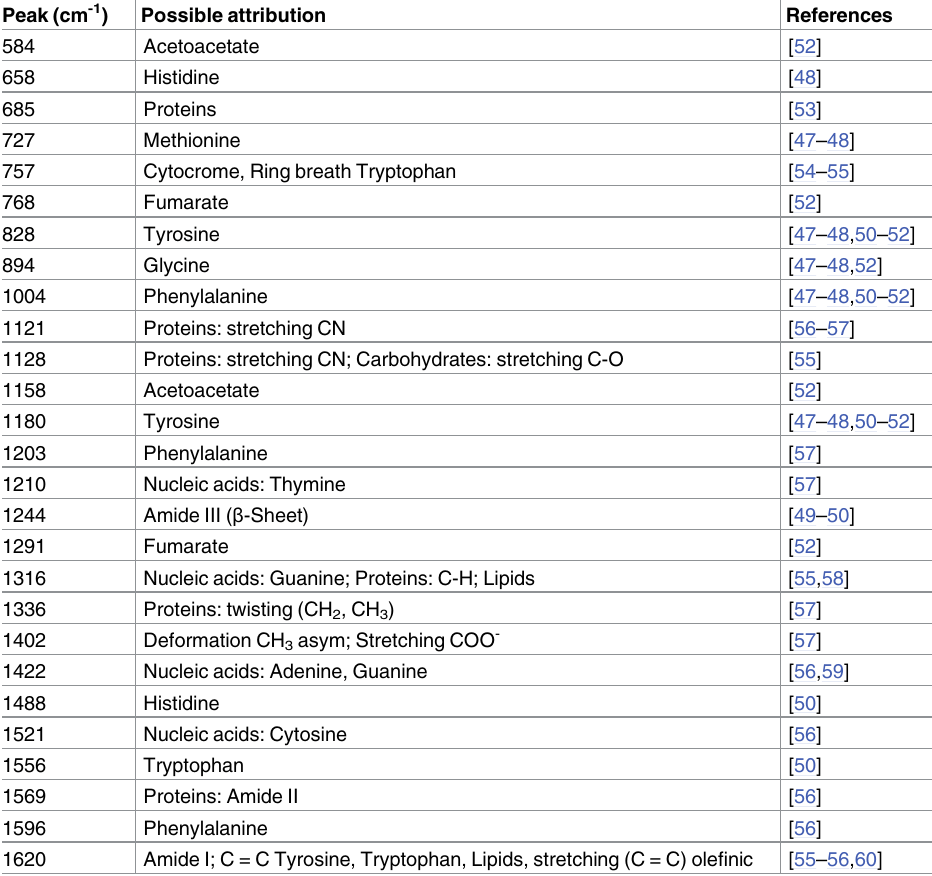
Table 1. Position and possible corresponding metabolite of the Raman peaks detected in the condi- tioned culture medium. Raman peaks detected in the cell culture medium and modulated in the intensity duringconditioning time are listed. For each of them, the positionin the spectrum and the possiblecorre- sponding metabolite, in accordancewith the literature, are reported. Peak (cm -1